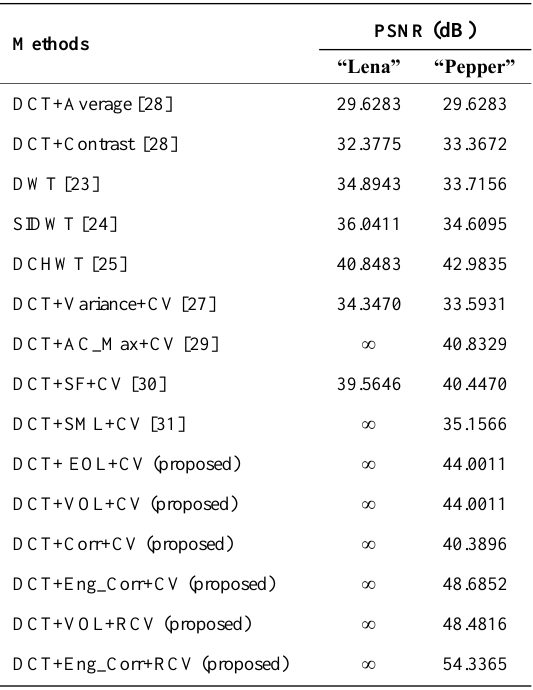
Table 4. PSNR comparison between multi-focus image fusion methods on “Lena” and “House” images.